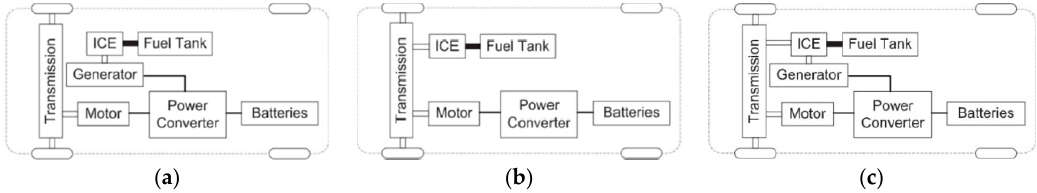
Figure 1. Three architectures’ configurations of a hybrid electric vehicle (HEV): ( a ) series hybrid; ( b ) parallel hybrid; and ( c ) series-parallel (SP) hybrid.